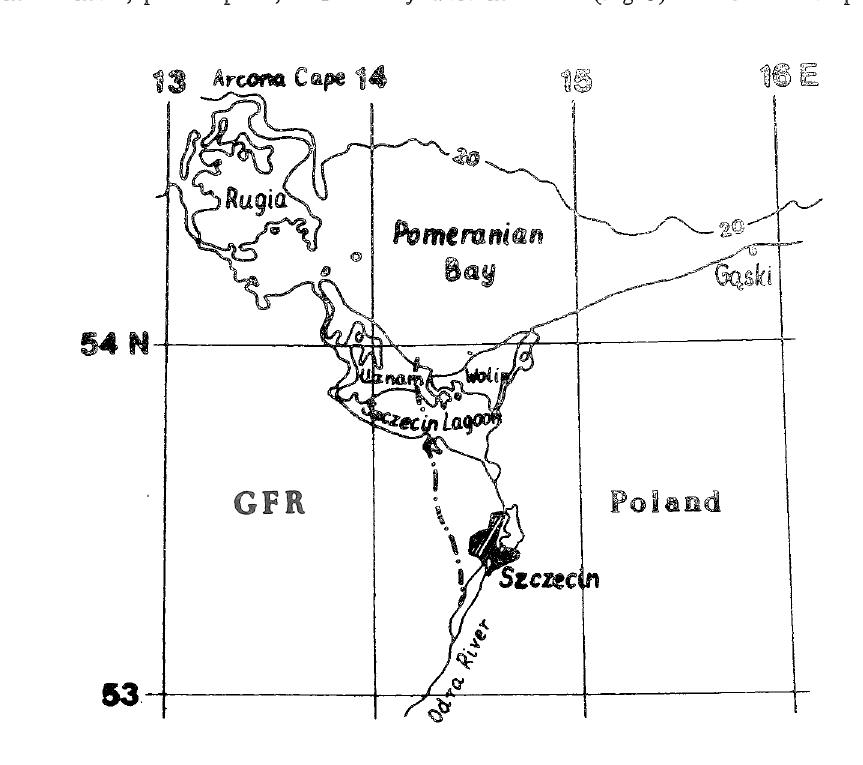
Fig. 3. Map of the Pomeranian